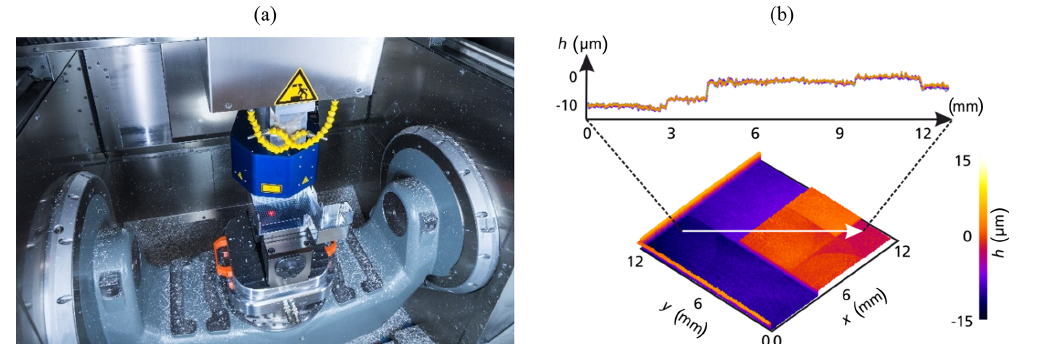
Figure 8. (a) Inspection of a typical milling surface by HoloPort inside a Hermle C32U 5-axis milling machine at Fraunhofer IPM. (b) Mea- sured height differences h between milling paths of a typical milled part in the range of 10µm. A cross section of 10 individual measurements at the same position demonstrates the measuring repeatability.